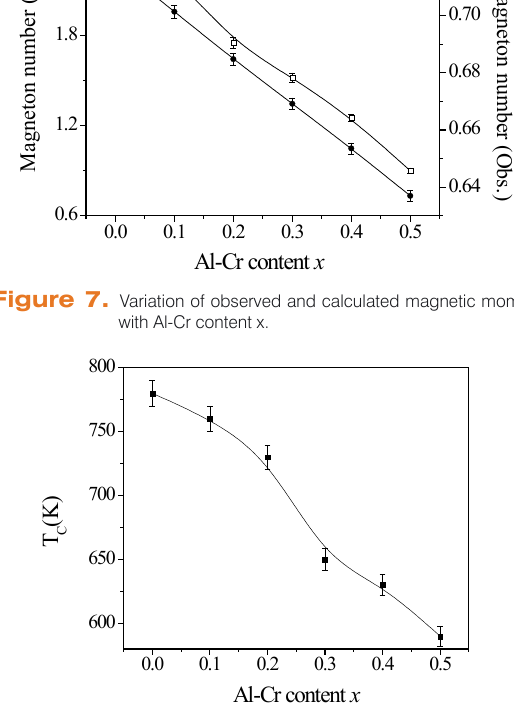
Figure 9. Variation of Curie tempeerature (T